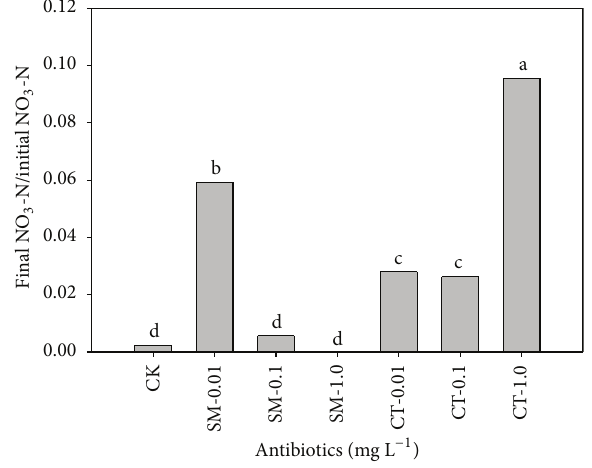
Figure 3: Comparison of final/initial nitrate (NO 3 -N) concentra- tions for sulfamethazine (SM-0.01, -0.1, and -1.0mg/L) and chlorte- tracycline (CT-0.01, -0.1, and -1.0 mg/L) after 19 days of incubation. Same letters above each bar indicate no difference between different treatments at a 0.05 significance level of the Tukey’s studentized range